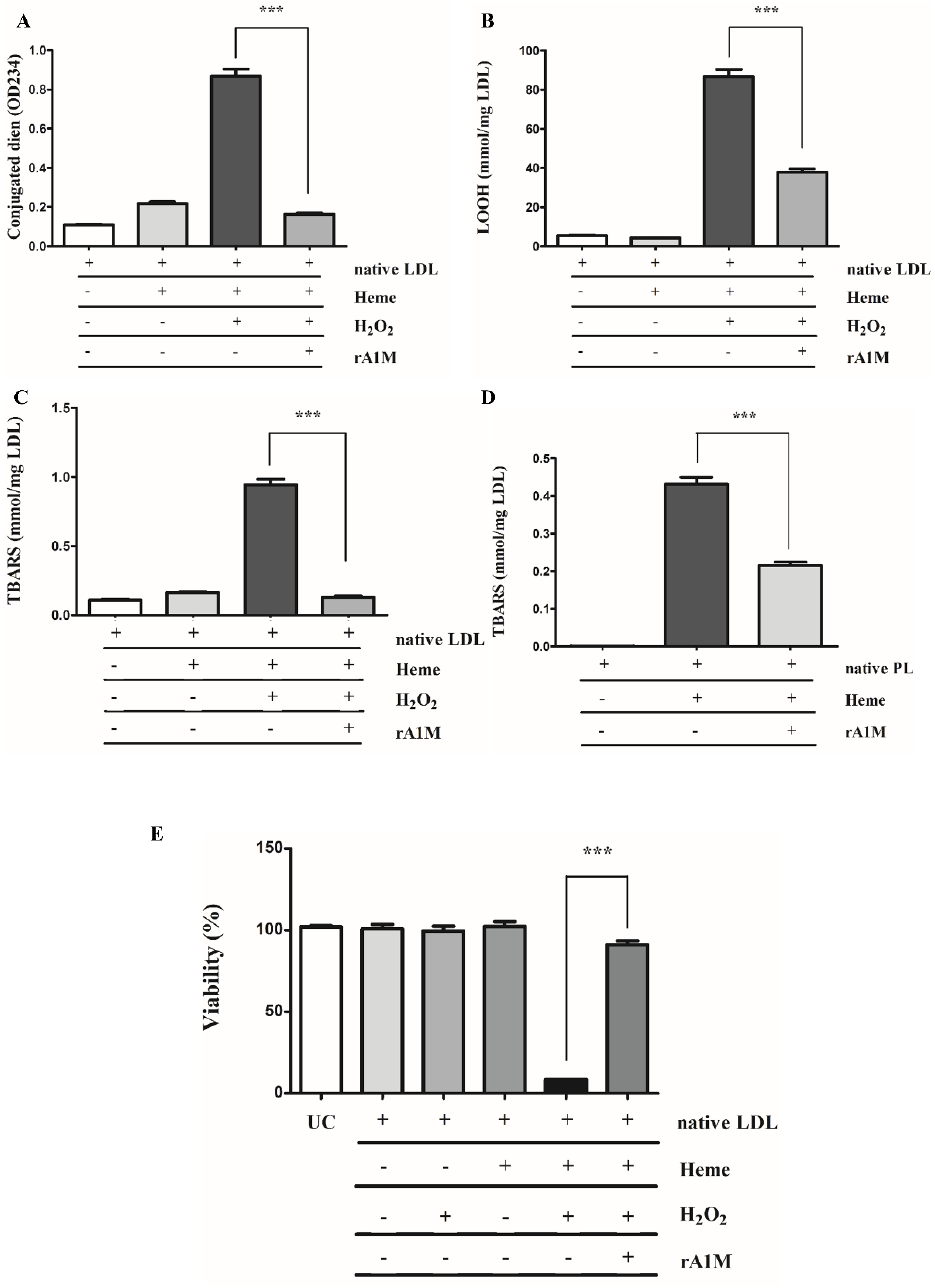
Figure 6. Recombinant A1M (rA1M) inhibits heme-catalyzed oxidation of low-density lipoproteins (LDLs) and plaque lipids as well as oxidized LDL-induced cell death. Native LDLs (200 µ g/mL) were incubated alone or in the presence of heme (5 µ M), heme (5 µ M) and H 2 O 2 (75 µ M), or heme (5 µ M) and H 2 O 2 (75 µ M) and A1M (10 µ M) in Hank’s balanced salt solution. Conjugated diene ( A ), total lipid hydroperoxides (LOOH) ( B ) and thiobarbituric-acid reactive substances (TBARs) ( C ) were measured. ( D ) Plaque lipids (500 µ g/mL), were incubated with heme (5 µ M) in the presence or absence of A1M (10 µ M) for 3 days at 37 ◦ C. Lipid peroxidation was assessed by measuring TBARs. ( E ) Confluent HAoECs grown in 96-well tissue-culture plates were washed twice with HBSS+ and exposed to native LDLs (200 µ g/mL), native LDLs (200 µ g/mL) and heme (5 µ M), native LDLs (200 µ g/mL) and H 2 O 2 (75 µ M), or native LDLs (200 µ g/mL), heme (5 µ M) and H 2 O 2 (75 µ M) in the presence of A1M (10 µ M) in HBSS+. Cells were then incubated at 37 ◦ for 6 h in a CO 2 incubator. Cell viability was assessed by MTT assay. UC: untreated cells. *** p <